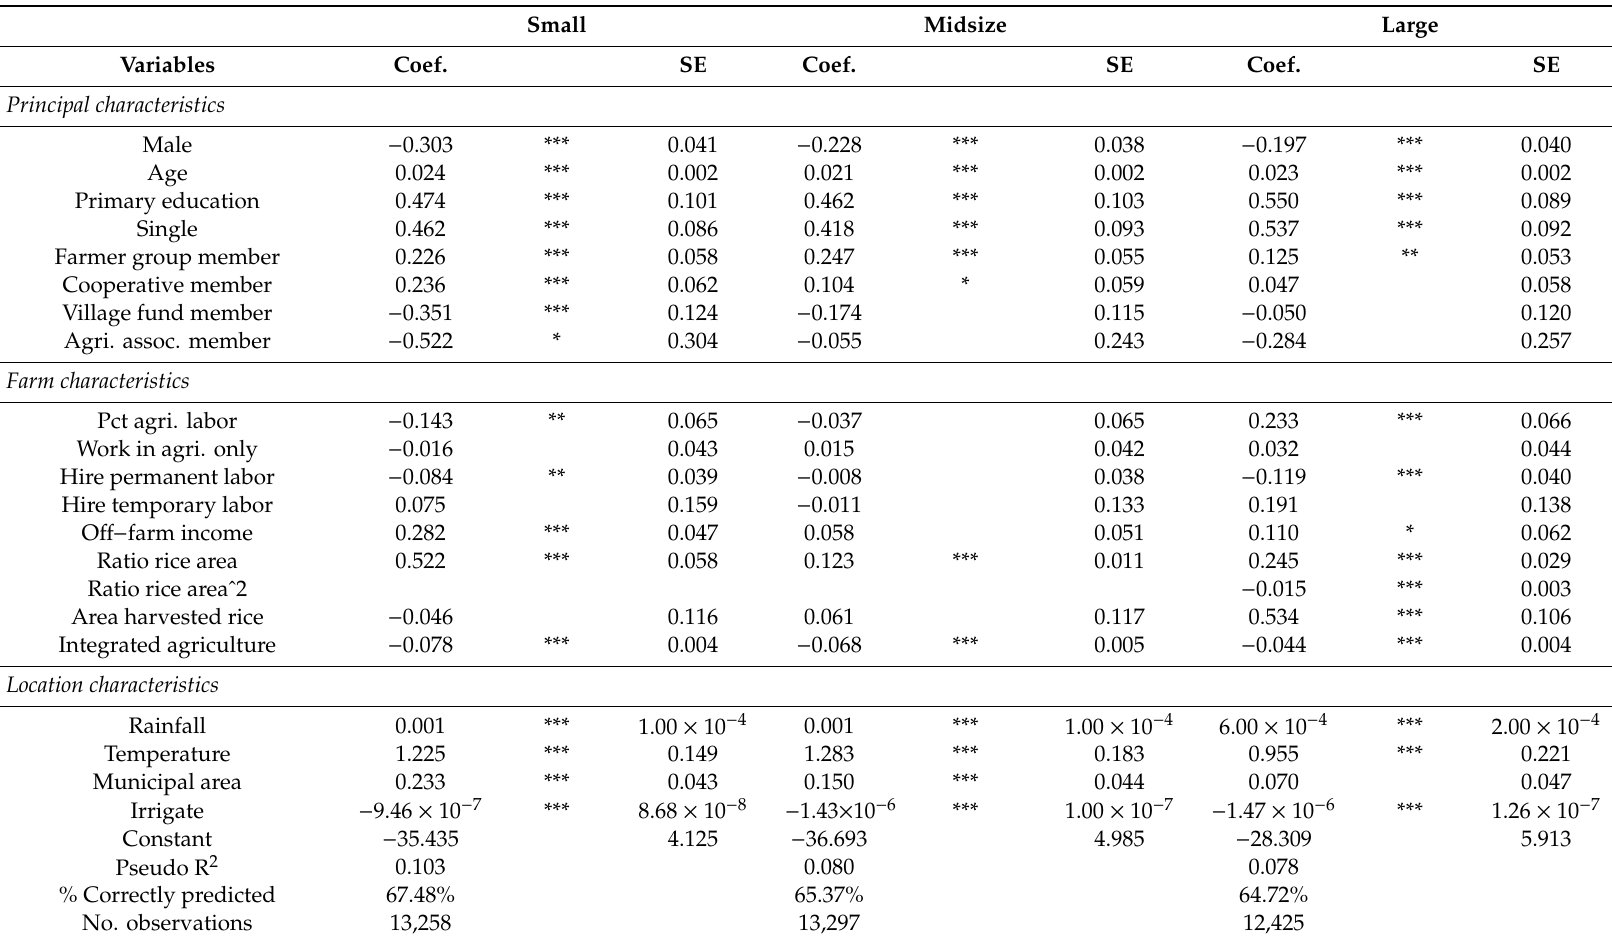
Table 4. Estimated coe ffi cients from logit models classified by farm type: full land ownership. Small Midsize Large Variables Coef. SE Coef. SE